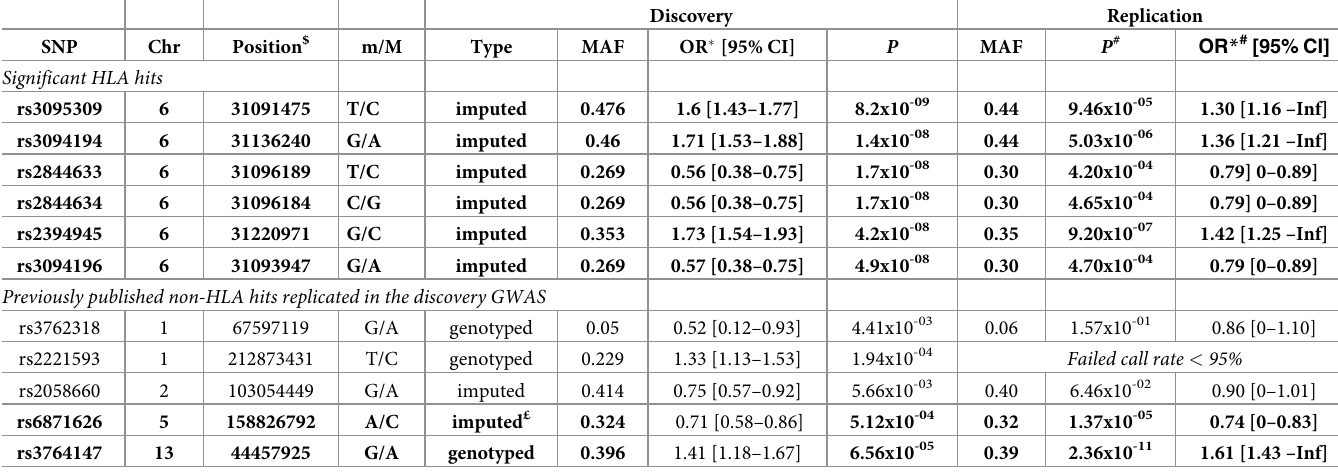
Table 1. Association statistics in the discovery and replication samples for the six genome-wide significant HLA SNPs and the five previously published non-HLA SNPs replicated in the discovery GWAS. Discovery